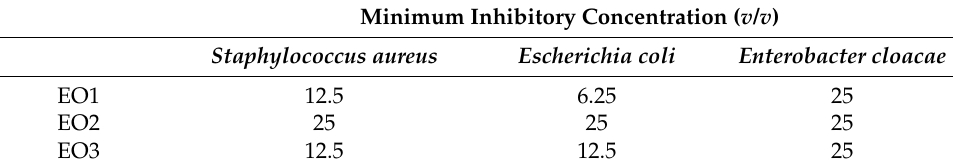
Table 2. The minimum inhibitory concentration of EOs as an antibacterial agent.